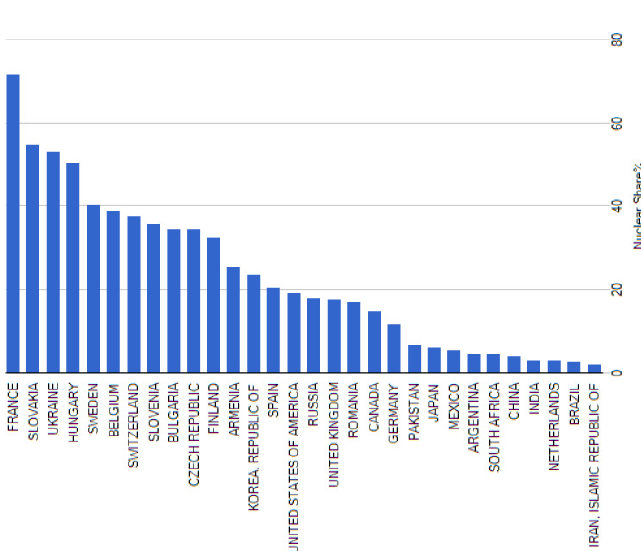
Fig. 8. – Nuclear share of electricity generation in each country (as of October 2019). Note: The share for Taiwan, China was 11.4% [6]. (Copyright c (cid:2) 2019 International Atomic Energy Agency (IAEA)).